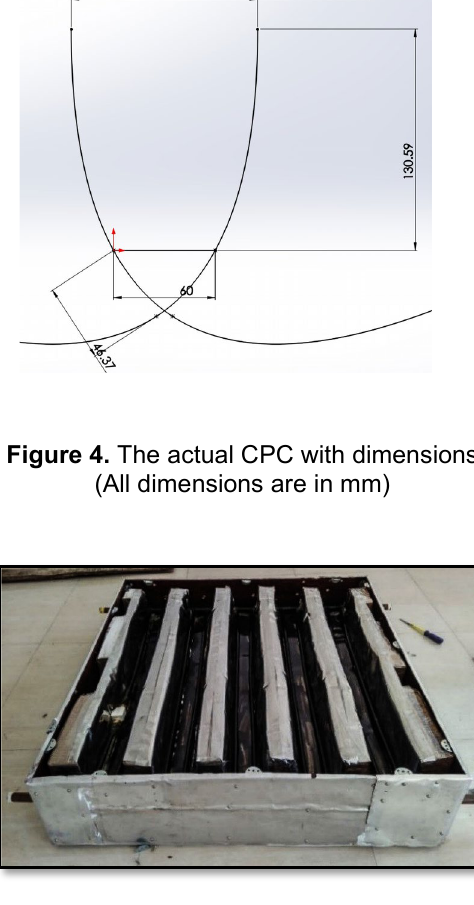
Figure 5. The fabricated